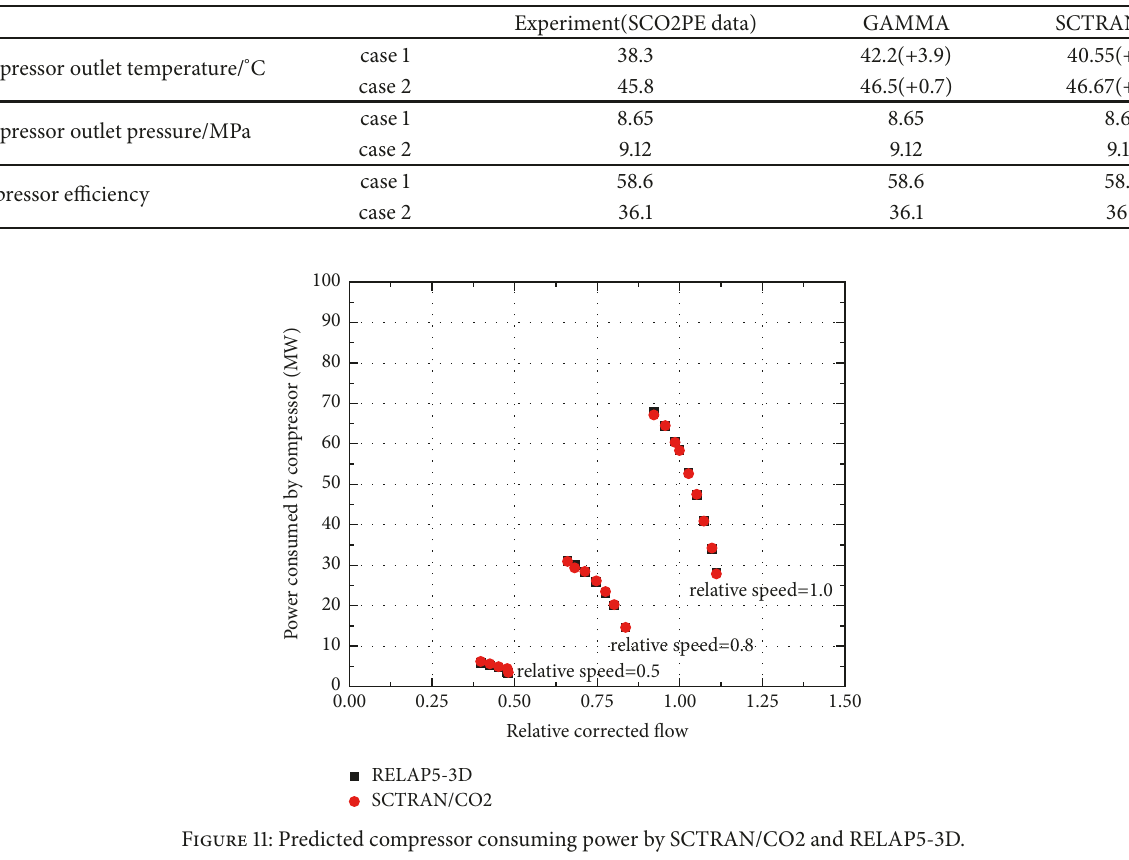
Table 4: Experiment data from SCO2PE and predicted result from SCTRAN/CO2 and GAMMA+ on the compressor outlet temperature.